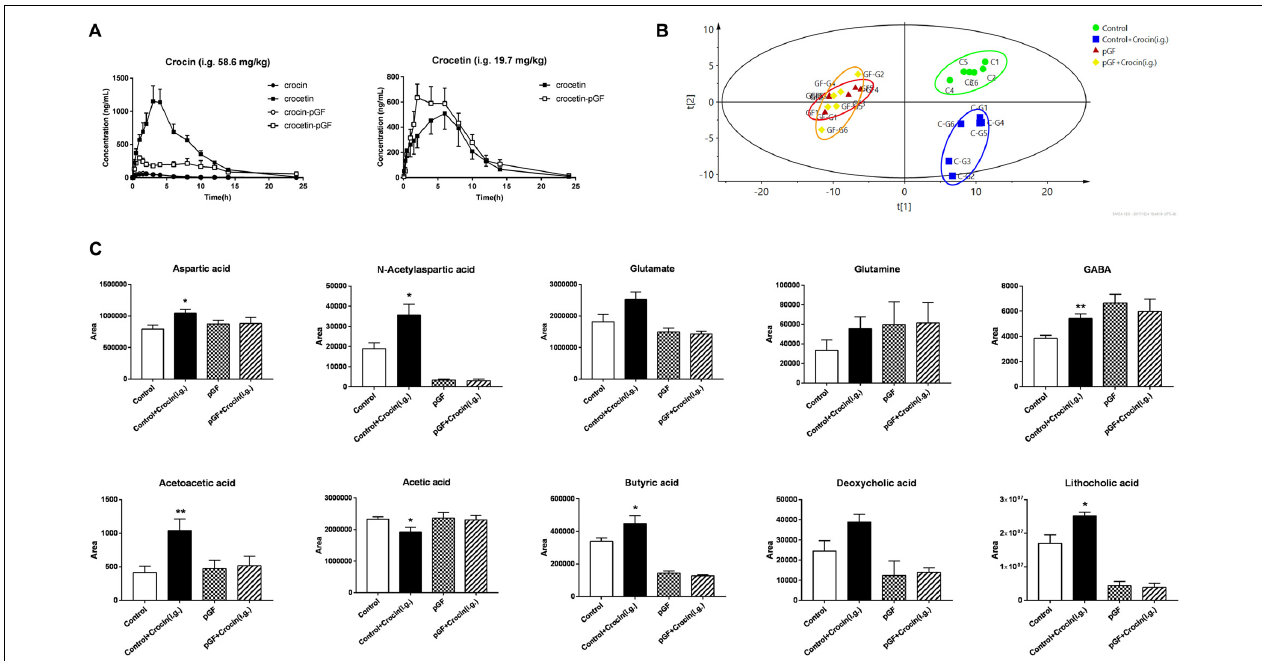
FIGURE 7 | The cross-interaction between gut microbiota and crocin was abolished in pGF rats. (A) PK curves of crocin and crocetin after oral administration (crocin, 58.6 mg/kg; crocetin, 19.7 mg/kg) (mean ± SD, n = 6); (B) PLS-DA scores plots of gut content collected 6 h after crocin or vehicle administration. (C) The metabolites identified to be significantly different between crocin administered and control rats, (mean ± SD, n = 6). ∗ P < 0.05, ∗∗ P < 0.01 vs. control